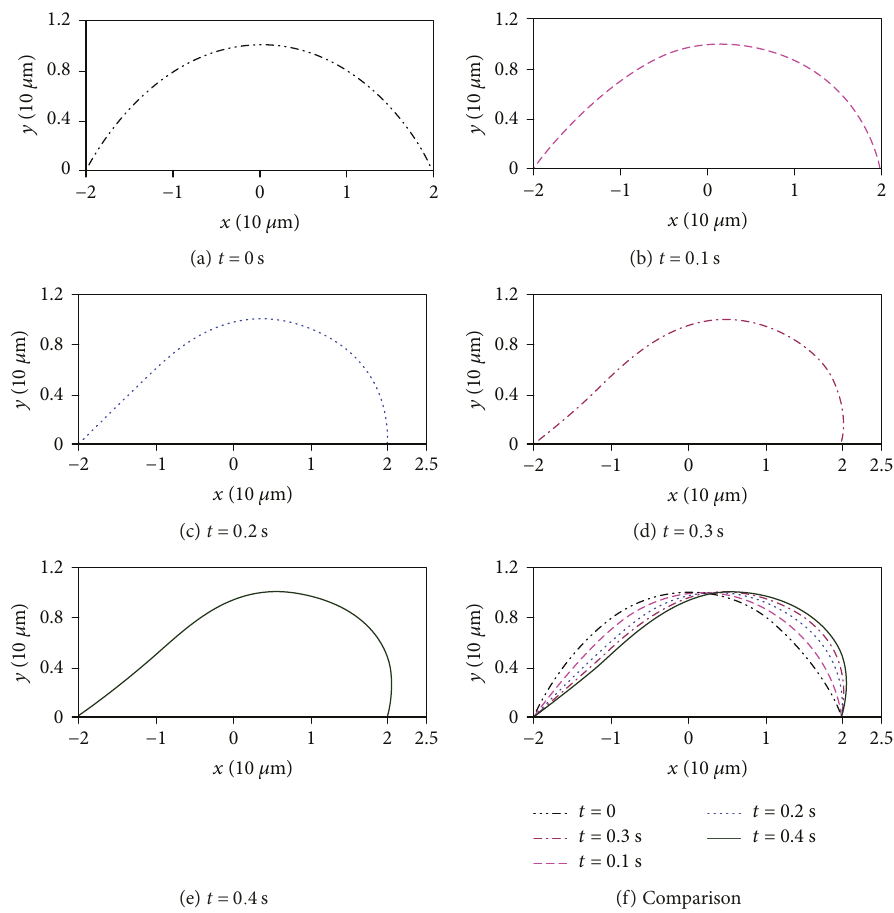
Figure 3: The deformation of residual oil with